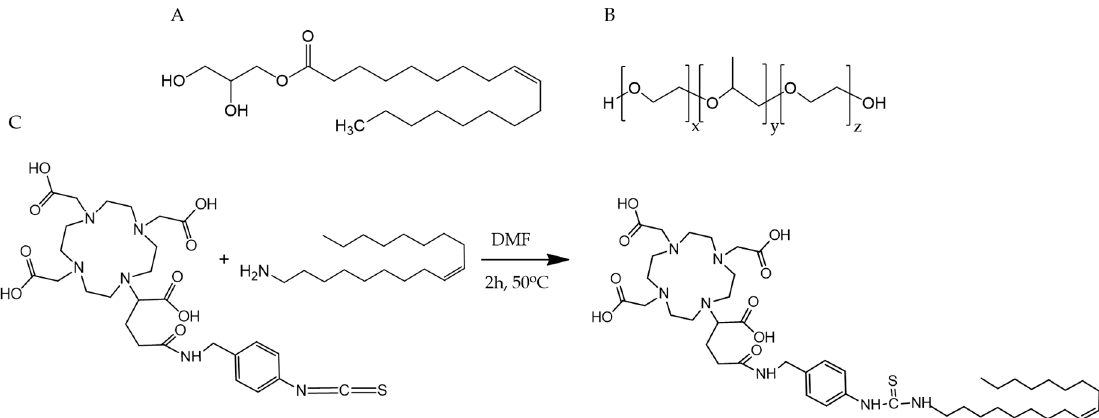
Figure 1. ( A ) Cubosome forming lipid, monoolein (GMO), ( B ) cubosome stabilizer, Pluronic F-127, and ( C ) synthetic scheme for cubosome dopant, DOTAGA-OA conjugate formation.